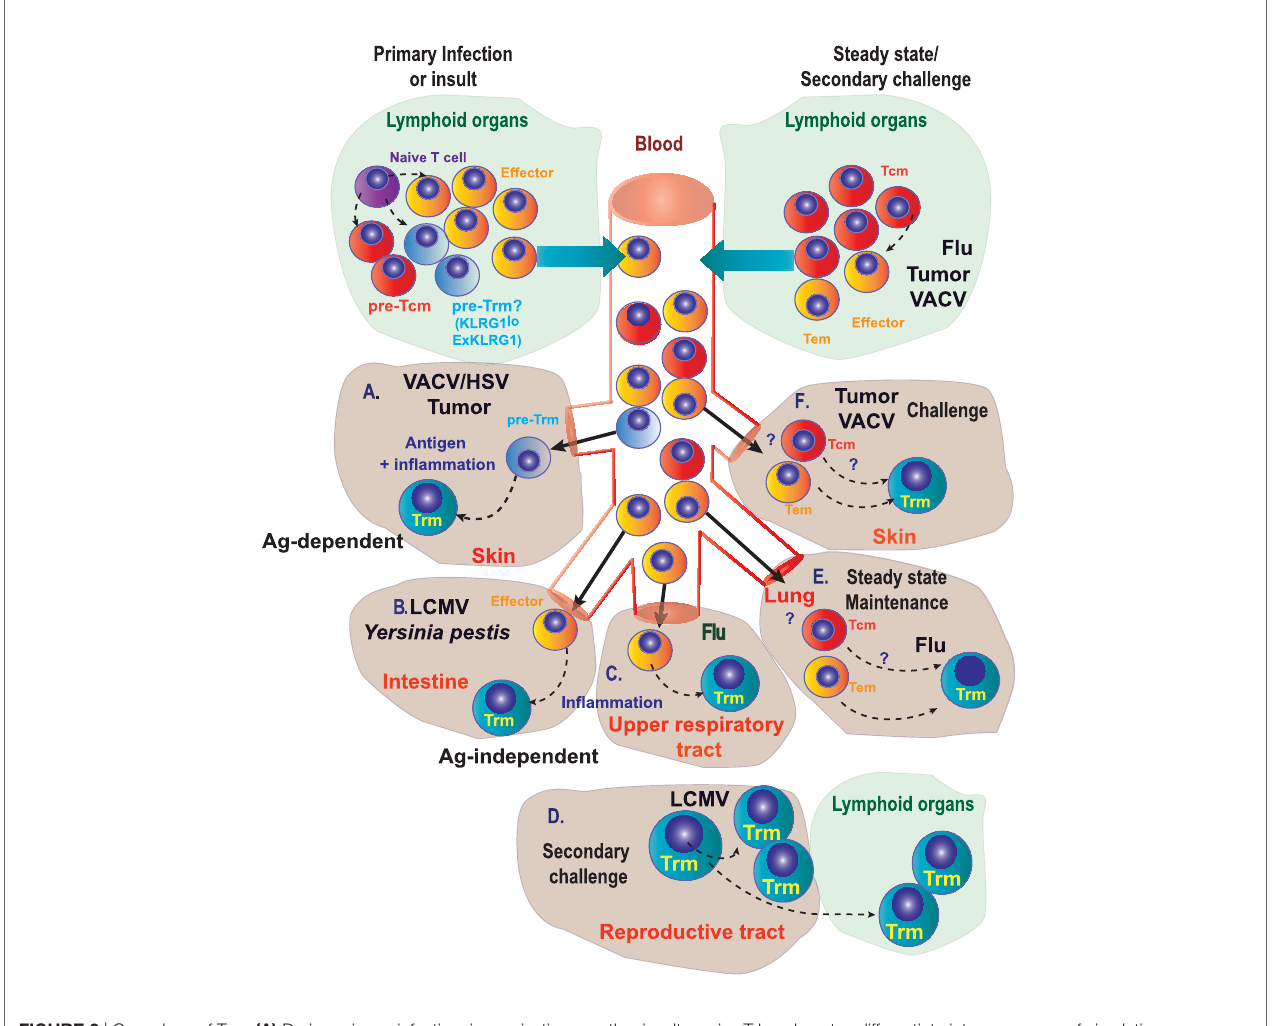
FiGURe 2 | Genealogy of Trm. (A) During primary infection, immunization, or other insults, naive T lymphocytes differentiate into precursors of circulating memory cells, effectors, and putative precursors of Trm (pre-Trm) cells that can differentiate into Trm cells in the skin, in response to viruses (VACV/HSV) or tumors. (B,C) Inflammation in the intestine (B) or in the upper respiratory tract (C) is able to promote Trm generation. (D) In the female reproductive tract, proliferating pre-existing Trm cells contribute substantially to the boosted secondary Trm population and can exit non-lymphoid tissues to convert into new Trm cells in lymphoid tissues. (e) Under steady-state conditions, circulating memory T cells can differentiate into Trm cells in the lung of mice previously infected with influenza A virus. (F) Circulating memory [effector memory T (Tem) or central memory T (Tcm)] cells can differentiate into Trm cells in the skin upon secondary challenge with viruses or